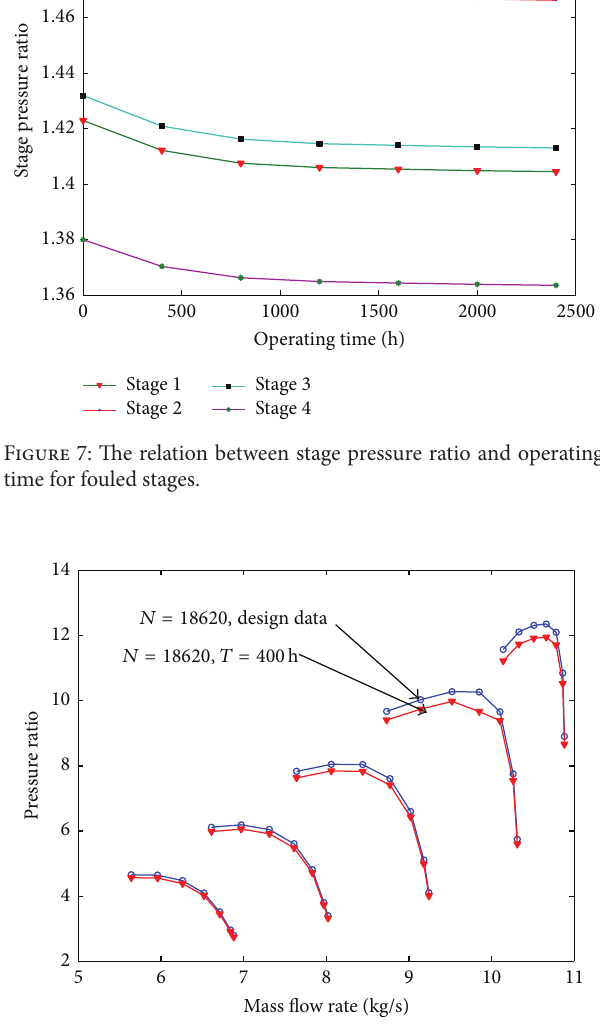
Figure 8: The pressure ratio curve in design and fouled condition when operating time is 400